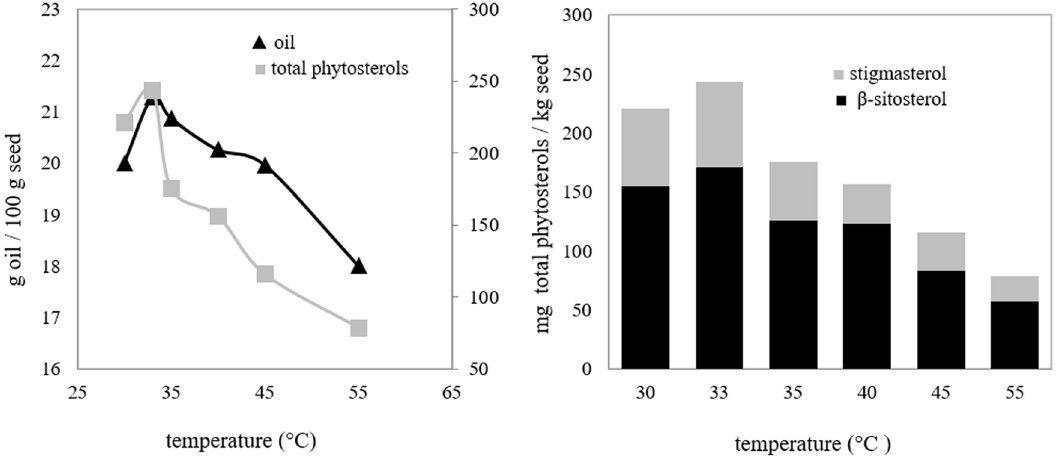
/min, 0.8 mm mean particle size, 2 2